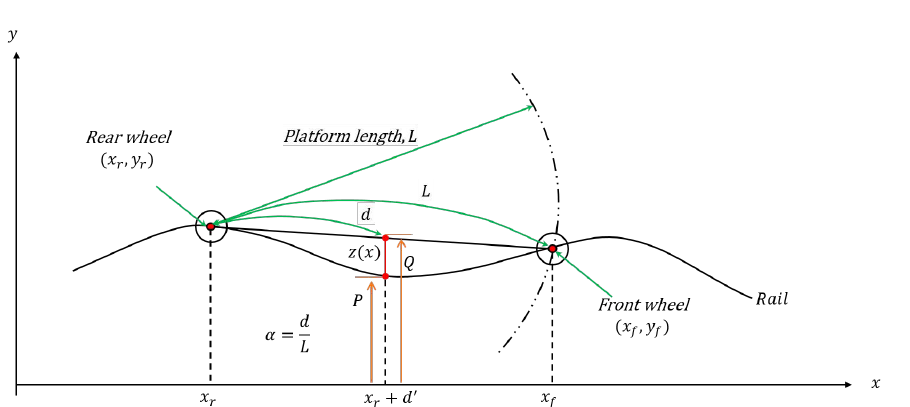
Figure 2. Single-sensor-based chord offset synchronizing model ( d is the distance between x r and the sensor, and d (cid:48) is the projection of d ) (Adapted and modified from